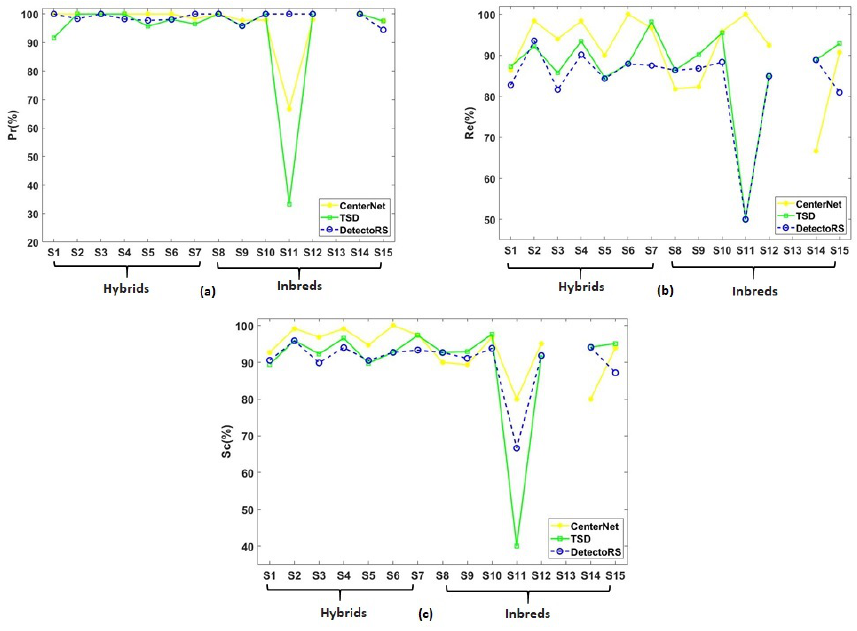
Figure 19. Results of Test (CenterNet: Yellow, TSD: Green, DetecoRS: Blue). ( a ) Precision (%). ( b ) Recall (% ). ( c ) Score (% ). The linear regressions between the manual counting and the predicted number of tassels using the three detection-based methods (CenterNet, DetectoRS, and TSD) and one regression-based method (Tasselnetv2+) are shown in Figure